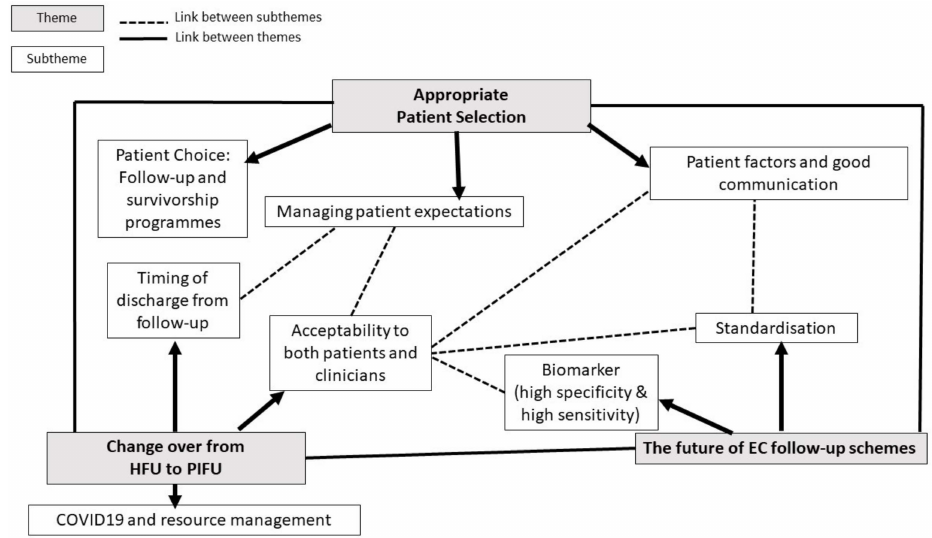
Figure 1. Themes and subthemes identified from the semi-structured interviews ( n =